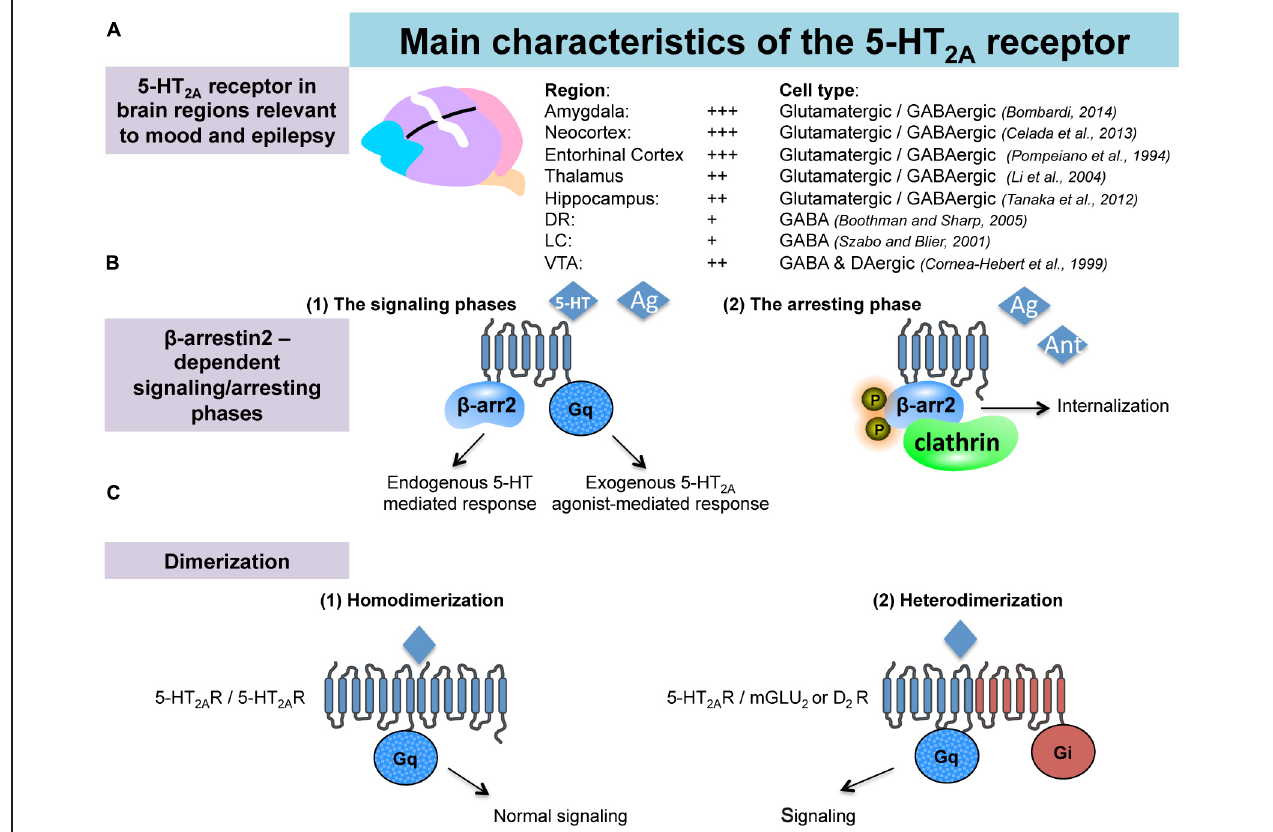
FIGURE 1 | Anatomical and pharmacological properties of the 5-HT2A receptors in the brain. (A) 5-HT 2A receptors (5-HT 2A -Rs) are located in brain regions involved in emotionality and epilepsy. (B) Interactions between 5-HT 2A -Rs and beta-arrestin 2. According to the nature of the 5-HT 2A -Rs agonist (endogenous/exogenous),